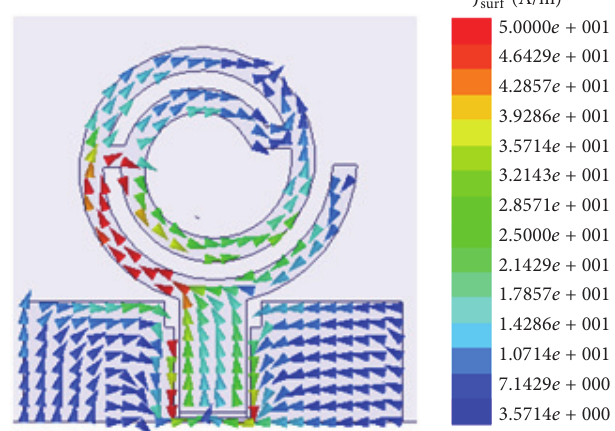
Figure 2: Current distribution of the proposed antenna at 1.4 GHz.